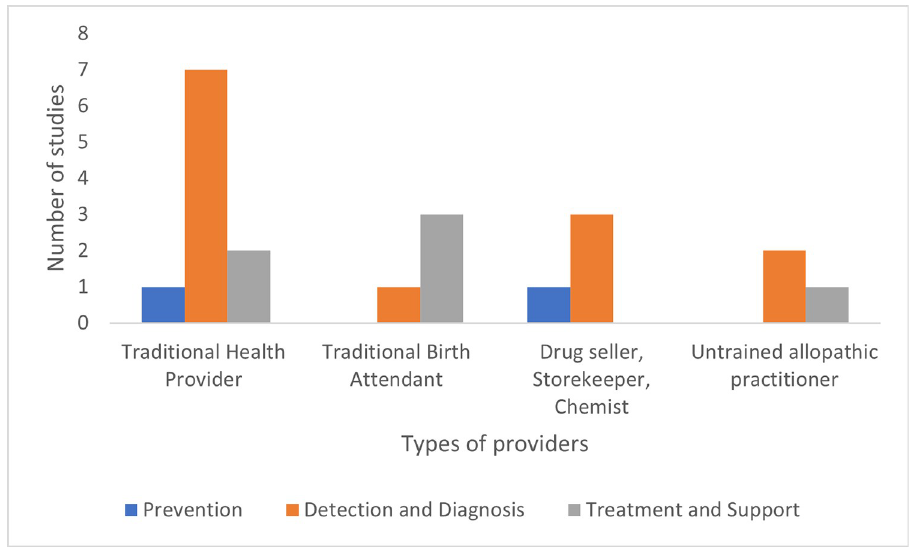
Fig 3. Bar diagram showing the distribution of IPs role by provider type (n = 21 a ). a Some studies featured more than one type of provider.